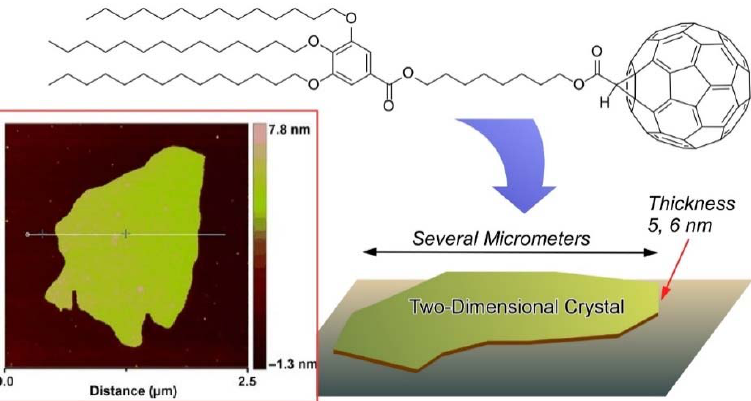
Figure 10. Formation of a thermotropic C 60 supramolecular nanosheet from molecules consists of a rigid C 60 , a gallic ester segment substituted with three long alkyl chains as the soft part, and a multi ‐ methylene unit as a flexible spacer connecting the two segments. Reprinted with permission from [121]. Copyright 2015 Wiley ‐ VCH.